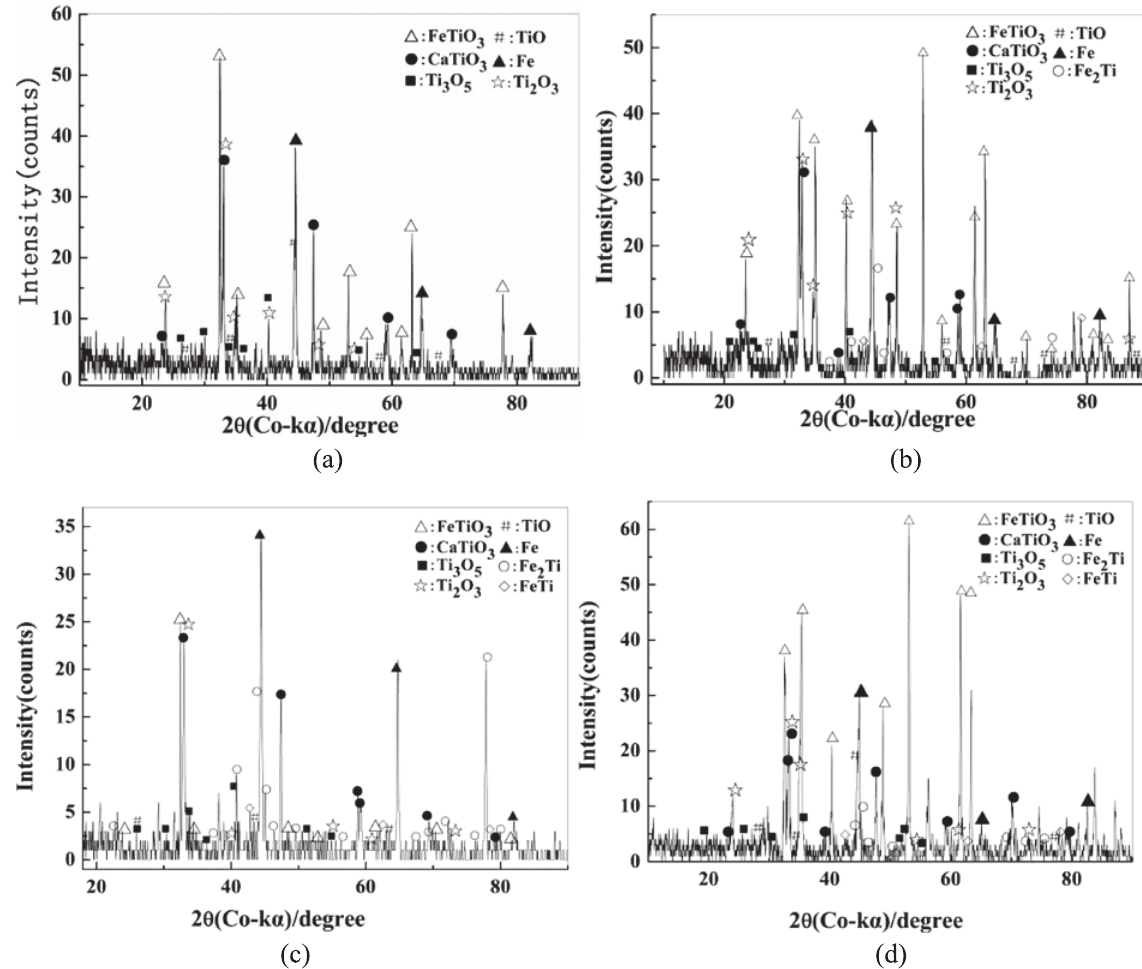
Fig. 5: XRD patterns of cross-section of sample electrolyzed at different times. (a) 0.5 h; (b) 2 h; (c) 6 h; (d) 10